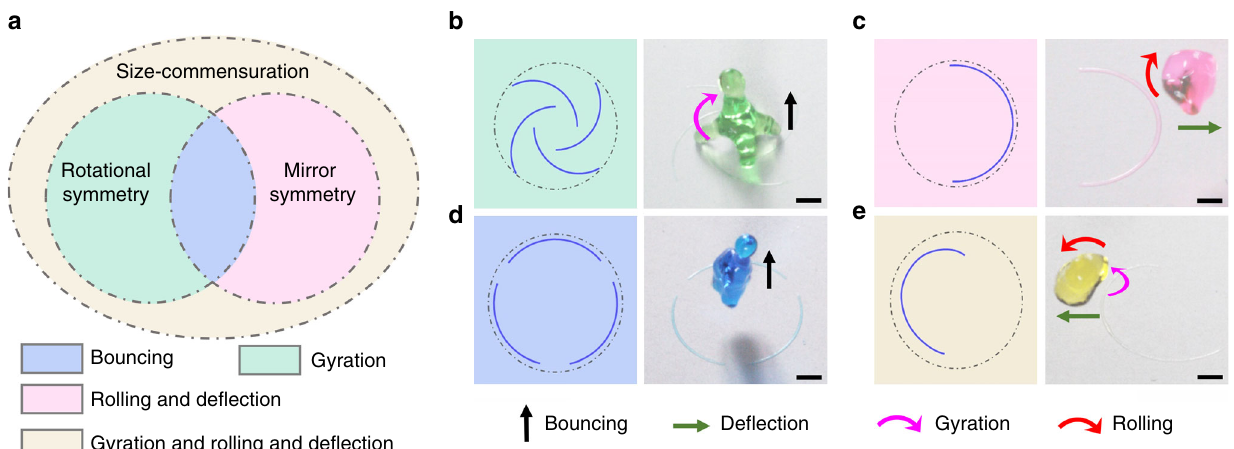
Fig. 4 Exploitation of pinning forces for various droplet actuation. a Effect of the size-commensuration, rotational symmetry, and mirror symmetry of the adhesion pattern under the droplet maximum spreading on the impacting behaviors. b The droplet upward bounces with gyration after impacting on a low- adhesive surface with high-adhesive arcs that has rotational symmetry but no mirror symmetry. c A droplet de fl ects and rolls after impacting on a low- adhesive surface with a high-adhesive arc that is mirror symmetric but not rotationally symmetric. d The droplet bounces vertically upward after impacting on a low-adhesive surface with high-adhesive circular segments that are rotationally and mirror symmetric. e A droplet gyrates, rolls, and de fl ects after impacting on a low-adhesive surface with a high-adhesive Archimedean spiral segment that is asymmetric. The schemes of the patterns are given in the fi rst column of b – e , in which the dashed circles represent the maximum spreading boundaries of the droplets. The scale bars are 1